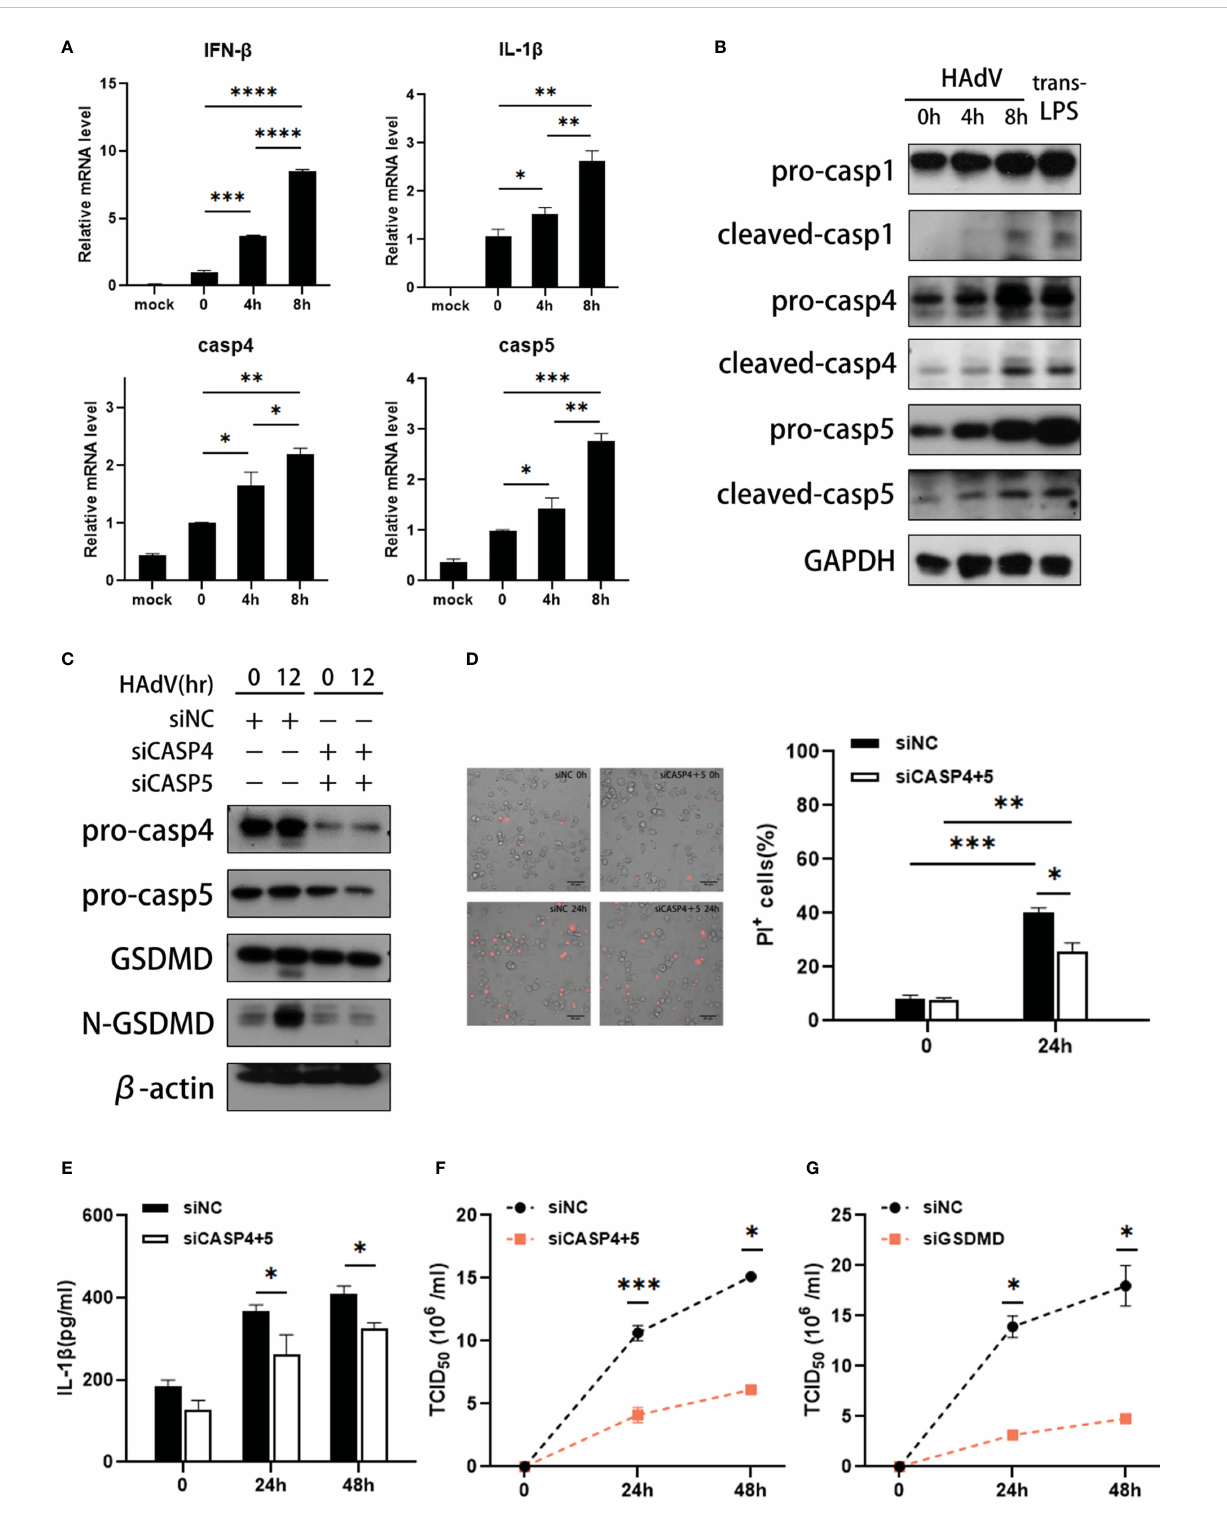
FIGURE 3 HAdV infection induced activation of caspase-4/5. The dTHP-1 cells were infected by HAdV (MOI=100) for indicated times and/or transfected LPS (2.5 m g/ml) for 8h. (A) The mRNA levels of IFN- b , IL-1 b , caspase-4/5 responses to HAdV infection at 0, 4, and 8h were measured by real-time PCR. (B) Western blot data showing expression of indicated protein in in dTHP-1 cells infected with HAdV at indicated times. (C) Western blot data showing expression of indicated protein in siCASP-4+5-treated dTHP-1 cells infected with HAdV at indicated times. (D) Representative images of dead cells stained with PI were observed by fl uorescent microscopy (magni fi cation: 20×, scale bar: 100 m m) and quanti fi cation of PI + cells. (E) IL-1 b secretion was tested by ELISA at 24h or 48h post-infection. The supernatants of (F) siCASP4+5 or (G) siGSDMD-treated vs siNC-treated dTHP-1 cells were collected for HAdV titer measured by the TCID 50 . Data are representative of two or three experiments. Error bars represent the mean ± SEM. * P value<0.05, ** P value <0.01, *** P value <0.001, **** P value